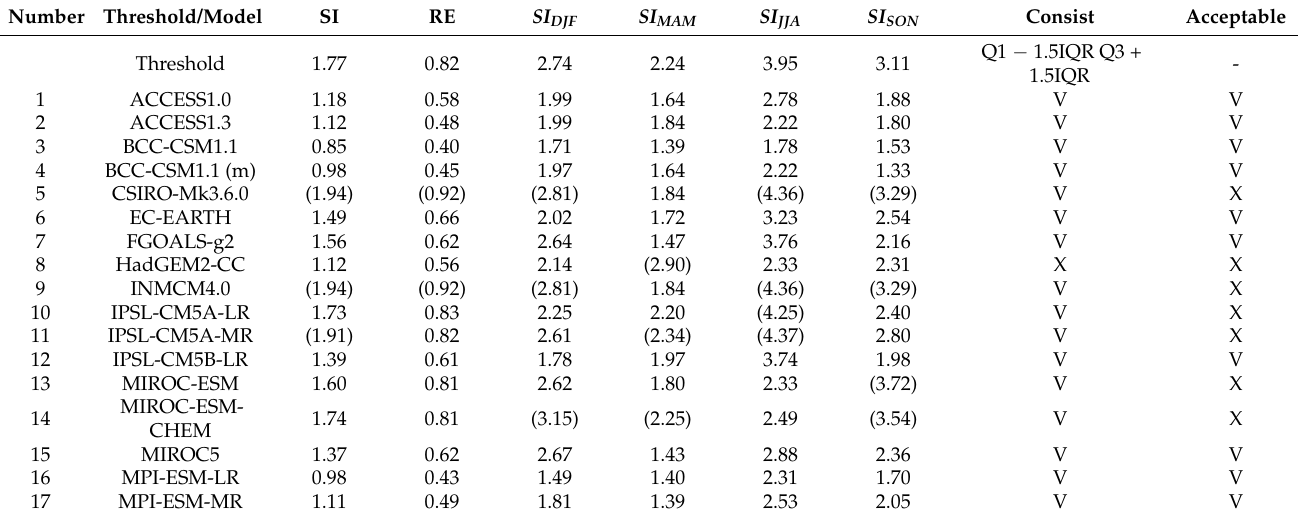
Table 1. Performance evaluation of 17 GCMs. Eliminated GCMs are marked as